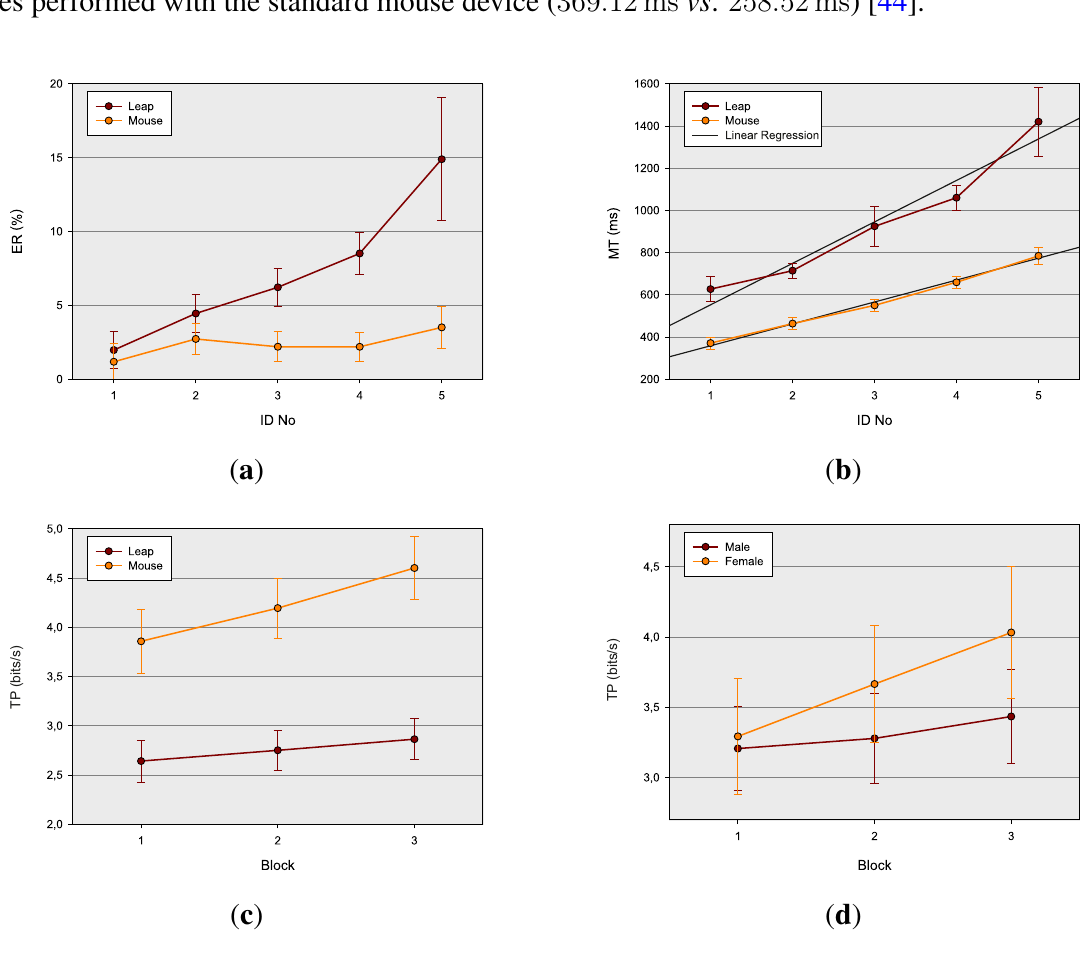
Figure 4. Results of the experiment: ( a ) error rate ( ER ) by device and index of difficulty ( ID ); ( b ) movement time ( MT ) by device and ID with linear regression lines fitted to the data; ( c ) throughput ( T P ) by block and device; and ( d ) T P by block and gender. Error bars indicate the 95 -percent confidence